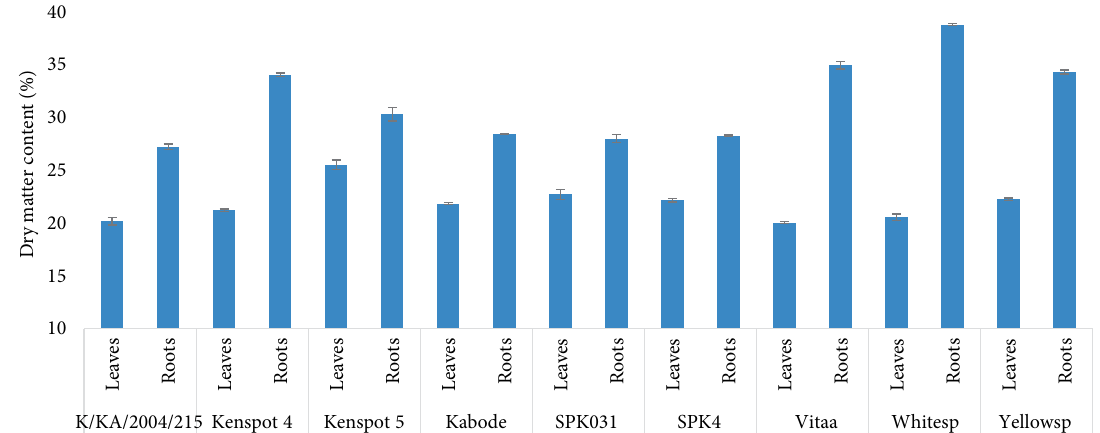
Figure 1: Variations in dry matter contents in leaves and roots of nine Kenyan sweet potato varieties. The bars indicate standard error of the